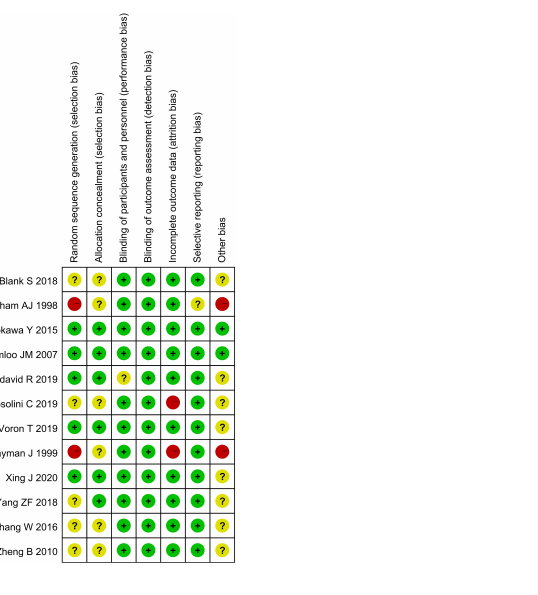
FIGURE 2 | Risk of bias summary for the included